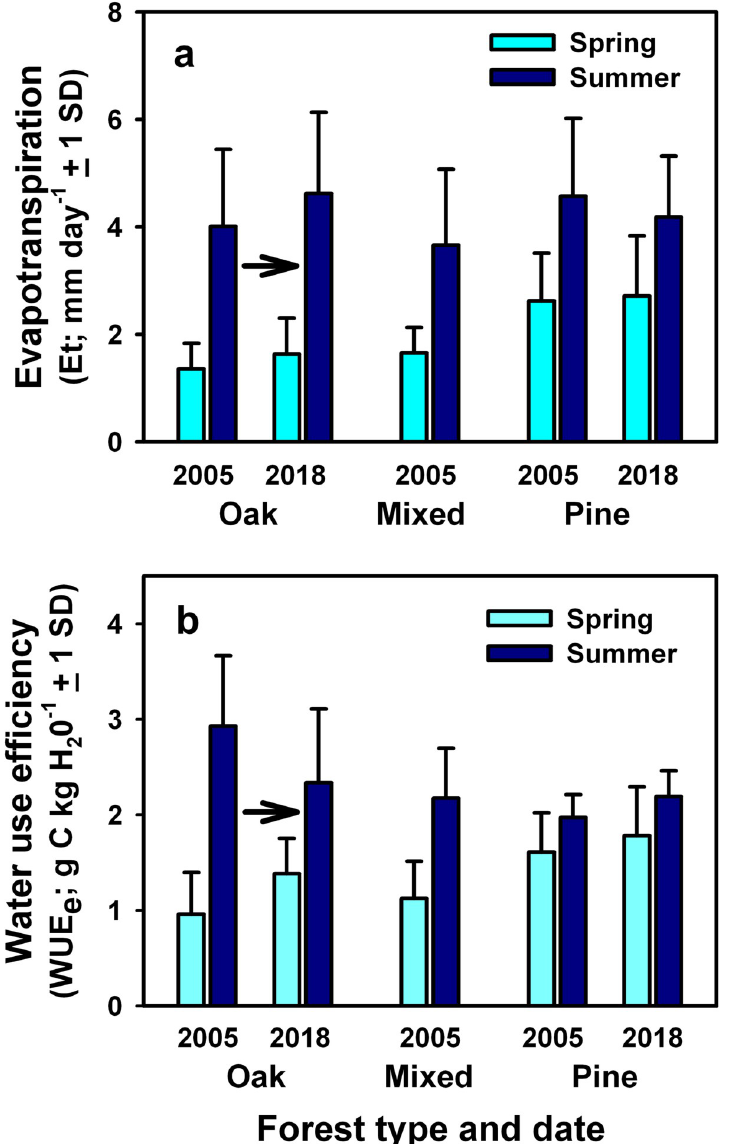
Fig 6. Evapotranspiration and water use efficiency of oak, mixed, and pine stands before L . dispar infestations in 2005 and following L . dispar infestations in 2018. Data are presented for (A) daily evapotranspiration, and (B) daily ecosystem water use efficiency during late spring (April 1 to May 15) and summer (June 1 to August 31) months. Arrows indicate the directional changes in forest structure and composition following L . dispar infestations. Pre- infestation data are adapted from Clark et al. [37,